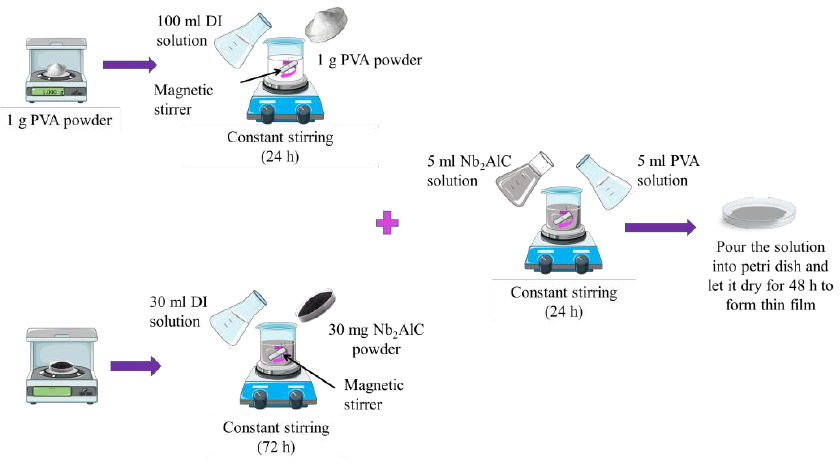
Figure 1. Nb 2 AlC-PVA preparation.